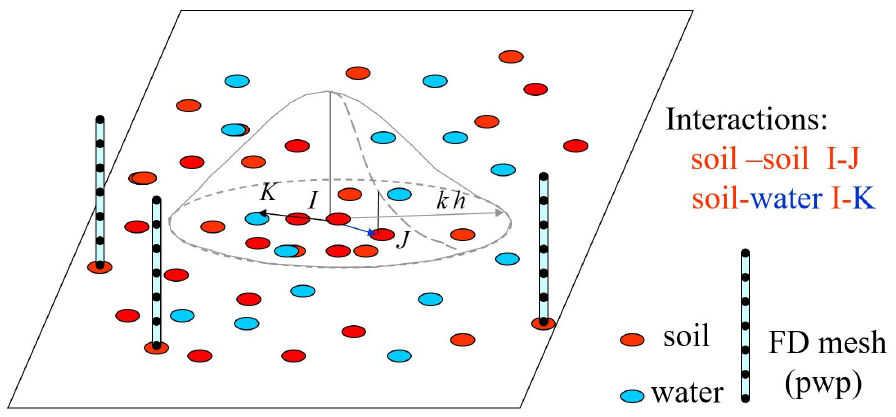
Figure 3. A 1D finite difference mesh at each SPH node representing solid